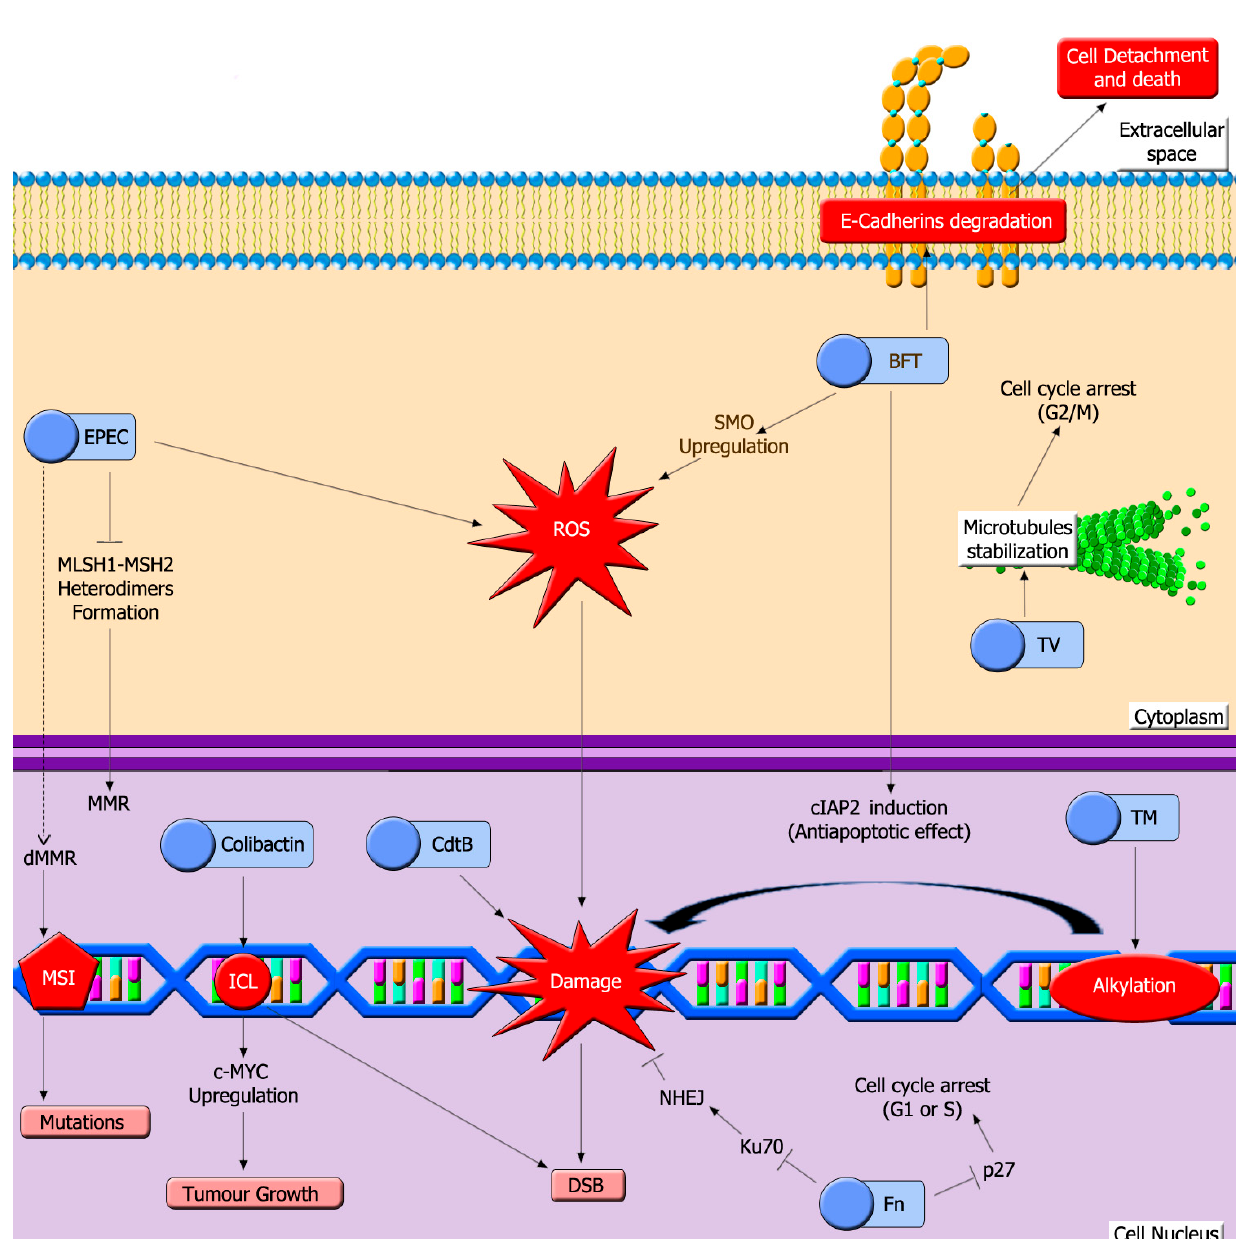
Figure 3. Bacterial toxins induce a high variety of DNA lesions in colon epithelium. A hallmark of colon dysbiosis is the growth of pathogenic bacteria that release toxins that induce DNA damage. Toxins depicted here can damage host DNA through different mechanisms, such as induction of interstrand crosslinks (ICL), generation of ROS, DNA alkylation or inhibiting MMR. EPEC: Enteropathogenic E. coli toxin, CdtB: Cytolethal distending toxin, BFT: Bacteroides fragilis toxin, Fn: Fusobacterium nucleatum toxins, TV: tilivalline, TM: tilimycin, MMR: mismatch repair system, dMMR: defective mismatch repair, MSI: microsatellite instability, DSB: double strand break.